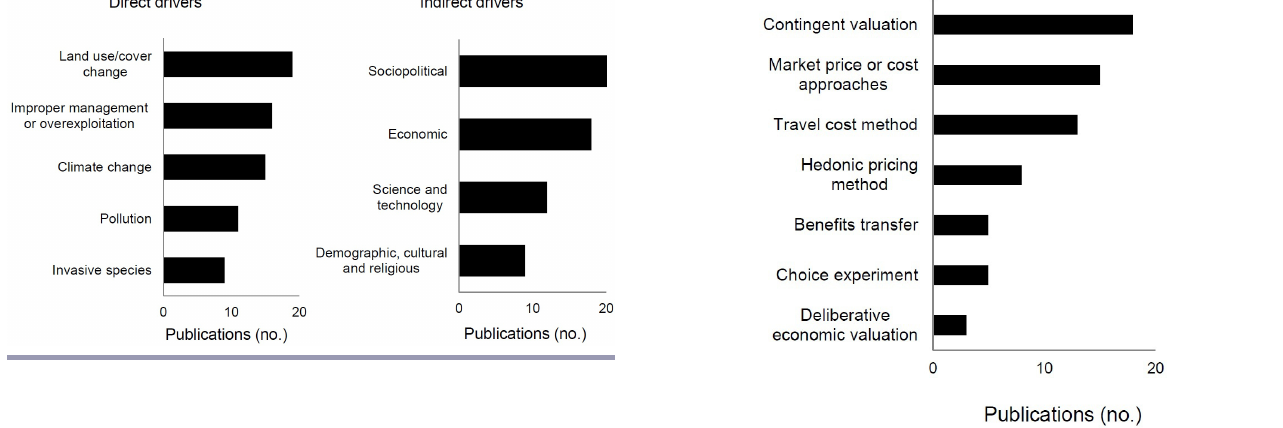
Fig. 5 . Number of publications applying or discussing different economic techniques used to value cultural ecosystem services. Some publications approached none or multiple of these